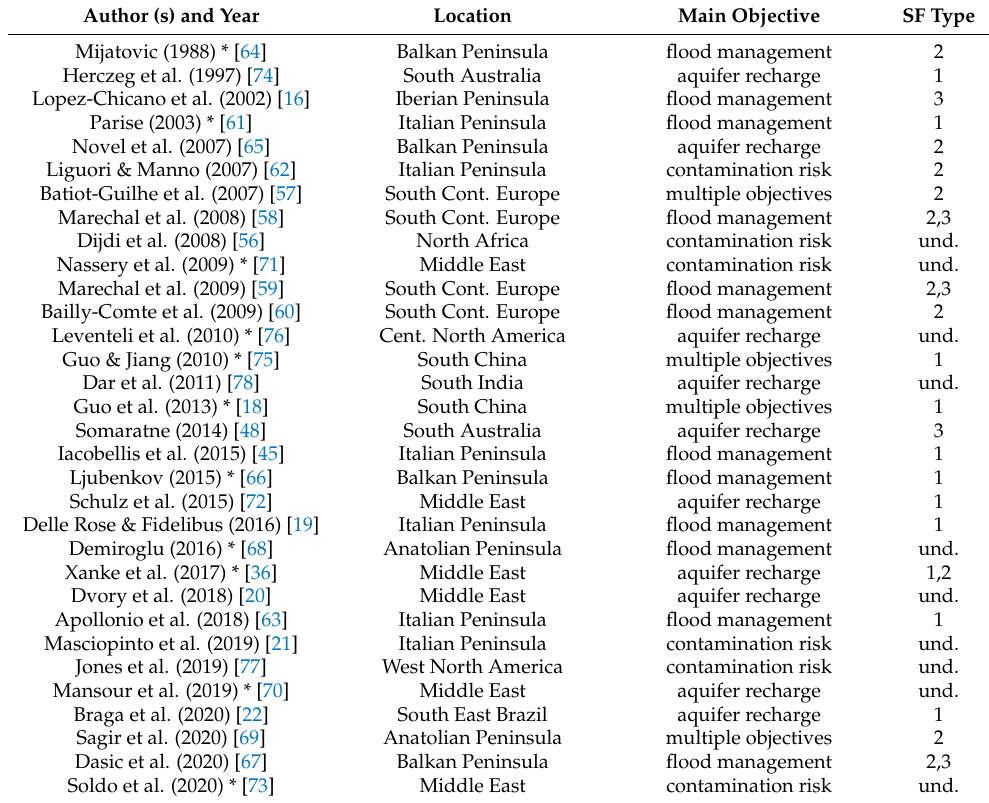
Figure 3. Location of reviewed cases study (see References numbering). Climatic regions map based on the Aridity Index in according to United Nations Environment Programme (UNEP) [79], modified after [80,81]. Areas: a, hyper arid; b, from arid to semi-arid; c, dry sub-humid. “Aquifer recharge” is the main objective for ten articles (third column of Table 1), while for the others it is “flood management” (twelve articles) or “contamination risk” (six). Four articles address “multiple objectives”. Twenty-two studies state the type(s) of examined SF or provide information for such classification. Table 1. Summary of reviewed studies. * = Added from other sources; und. = undetermined type; Cont. = Continental; Cent. =